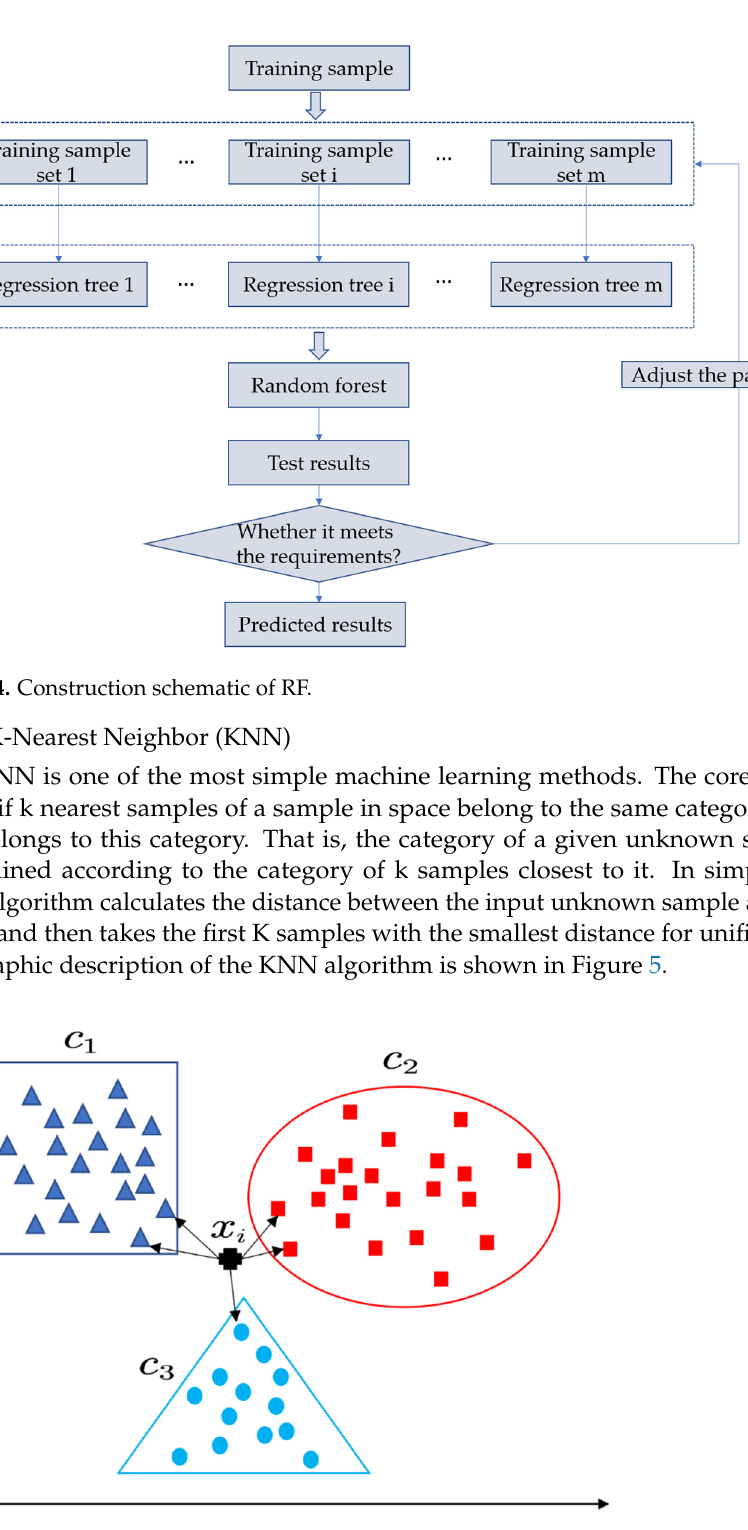
Figure 5. Graphic description of KNN (samples are represented by different color and shape).